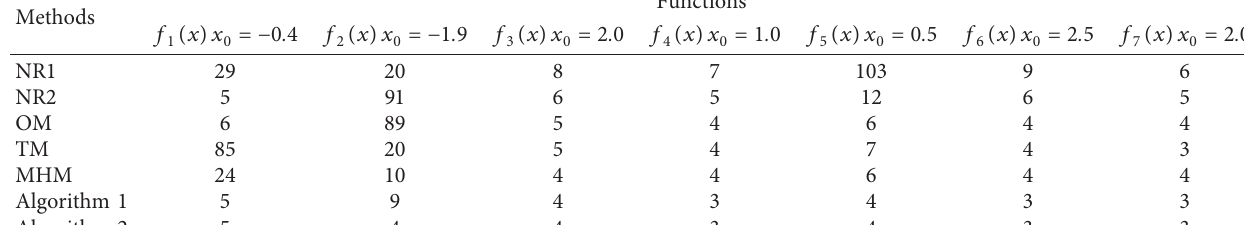
Table 8: Comparison of the number of iterations required for different iterative methods for ε � 10 − 100 .